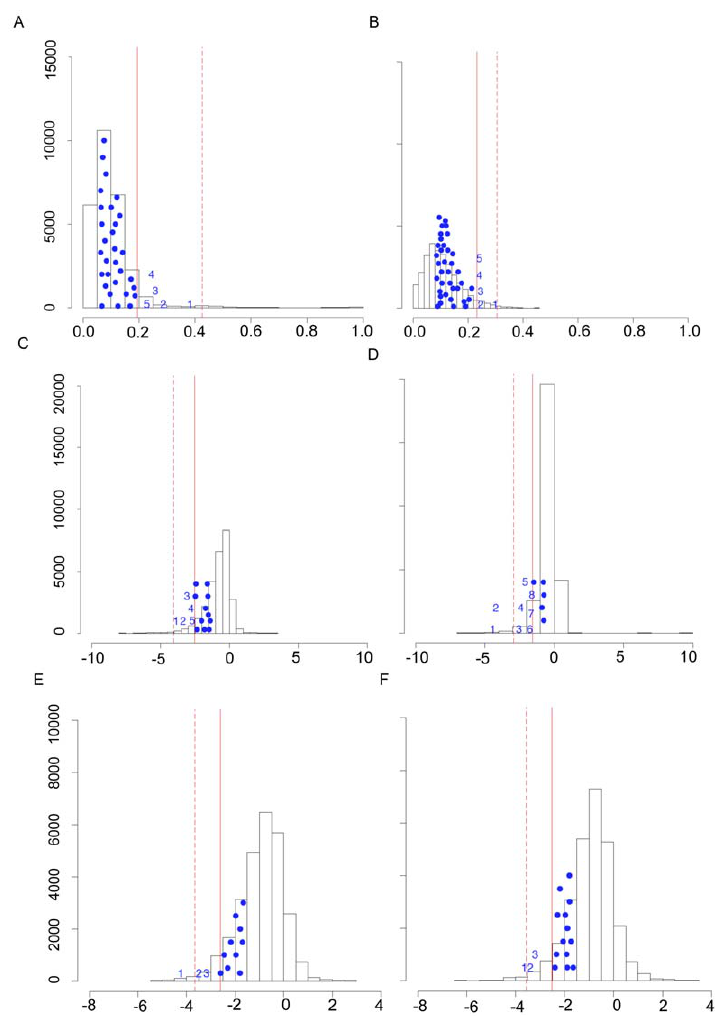
Figure 3. HIF pathway candidate genes showing evidence of positive directional selection in Andeans and Tibetans. The most significant test statistics for the HIF pathway candidate genes are plotted against the null distribution generated by plotting the highest ranked (i.e. most significant) test statistic for each gene from the dataset for LSBL in (A) Andeans and (B) Tibetans, for ln RH in (C) Andeans and (D) Tibetans, and for the standardized difference of D for in (E) Andeans and (F) Tibetans. The solid line indicates the 5% empirical cut off and the dashed line indicates the 1% empirical cut off for each distribution. The maximum test statistic for each of the HIF pathway candidate genes that had one or more SNPs falling in the top 5% of the empirical distribution is plotted on the figure as a solid circle. Those SNPs that fall in the top 5% of the empirical distribution and that are significant under the null distribution shown here for each population are plotted as numbers. In Figure A, 1= EGLN1 , 2= NOS2A , 3= TGFA , 4= CXCR4 , and 5= PRKAA1 . For Figure B, 1= EPAS1 , 2= EPO , 3= CASR , 4= EDN1 , and 5= EGLN1 . For Figure C, 1= ELF2 , 2= IL1A/ IL1B , 3= TNC , 4= FRAP1 , 5= POLR2A . For Figure D, 1= PIK3CB , 2= COPS5 , 3=EGLN1 , 4=VEGFC , 5=IL1B , 6=EPAS1 , 7=RBX1 , 8=IL1A . In Figure E, 1= PRKAA1 , 2= NOS2A , 3= EDNRB . For Figure F, 1= EPAS1 , 2= ARNT , 3= ADRA1B